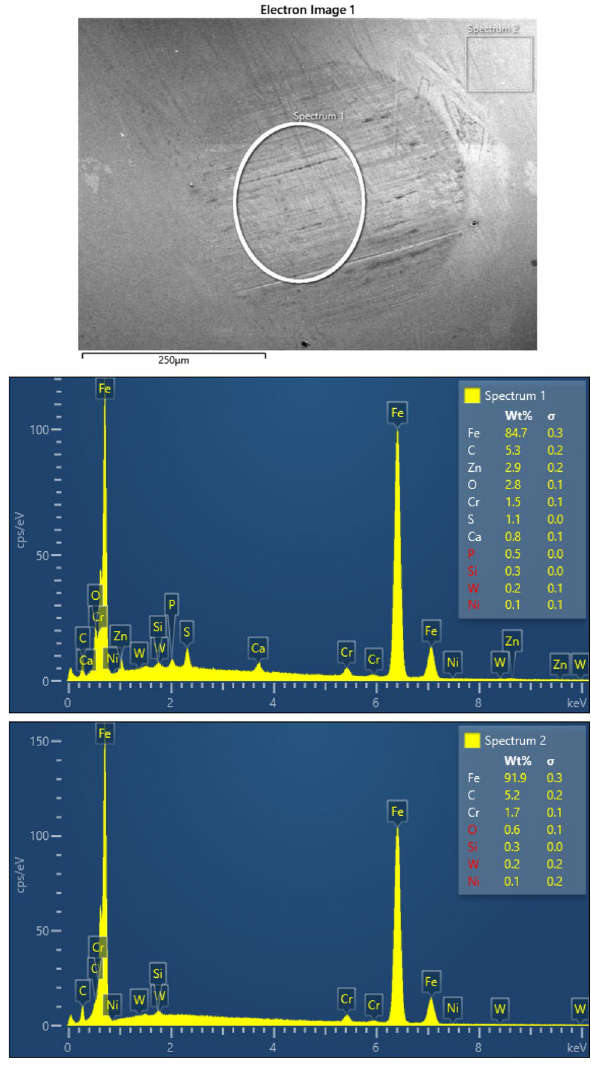
Figure 8. SEM and EDS analysis of worn surface of steel ball after four-ball test lubricated by the pure based oil at 75